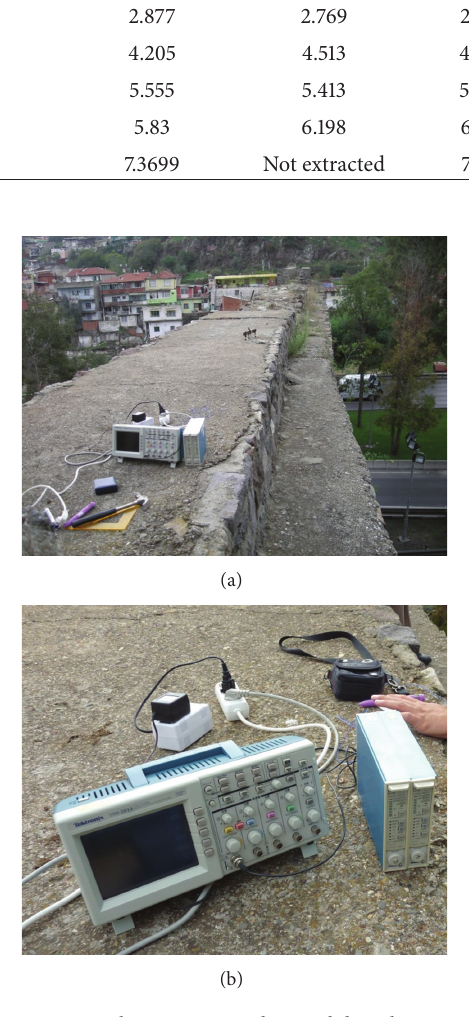
Figure 4: Impact-echo test on aqueduct and digital storage oscillo- scope.